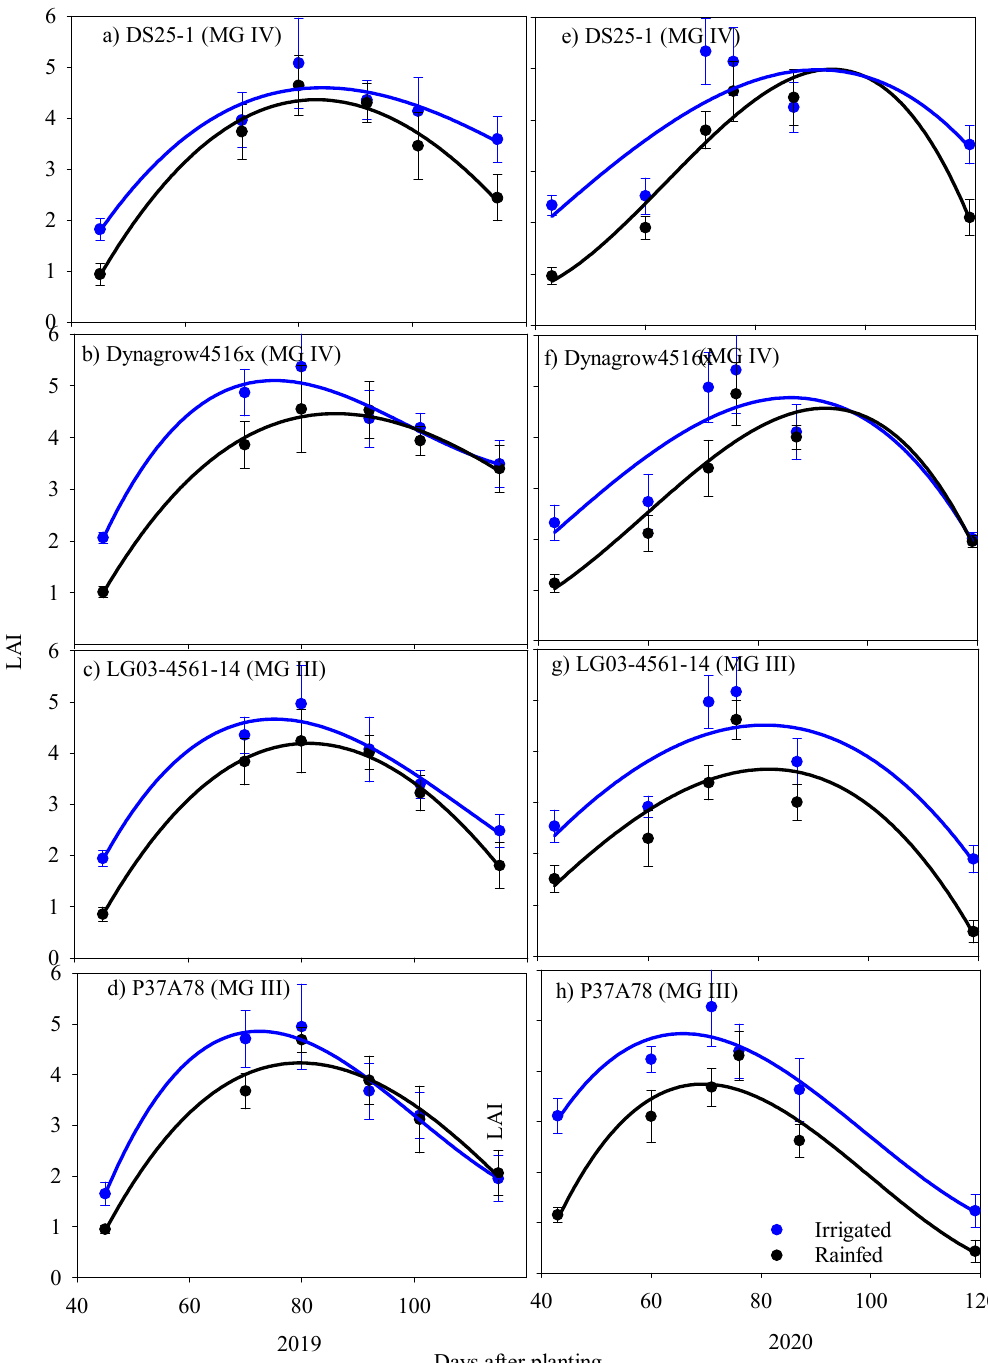
Figure 3. Leaf area index variability in the four soybean cultivars viz., DS25-1, Dyna-gro 4516x, LG03-4561-14, and P37A78 in rainfed and irrigated conditions during 2019 and 2020. Each data point represents five readings and three replications. A global curve was fitted to the measured LAI using Sigma Plot v14.